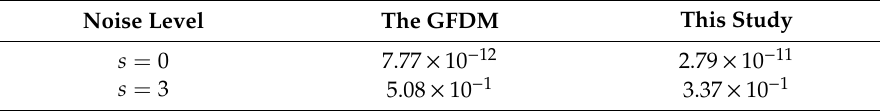
Figure 21. Boundary and source points. Table 3. The MAE by assigning di ff erent levels of noise for example